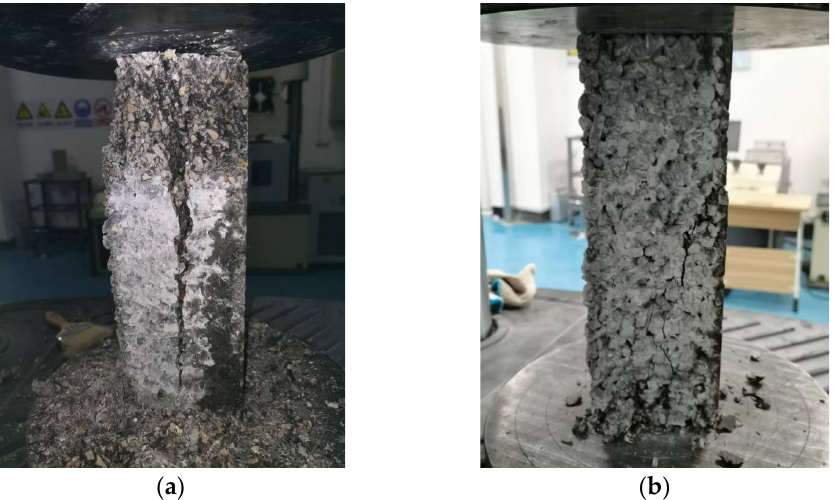
Figure 4. The failure patterns of ( a ) concrete prism without basalt fiber and ( b ) concrete prism with basalt fiber under axial compression.